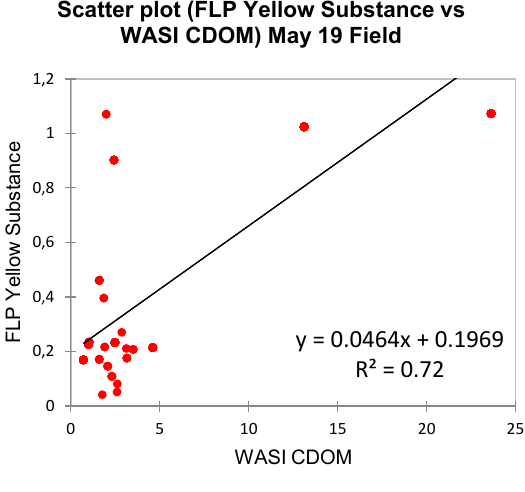
Figure 6. Scatter plot of Fluoroprobe Yellow Substance concentration vs. WASI CDOM output for the May 19 image